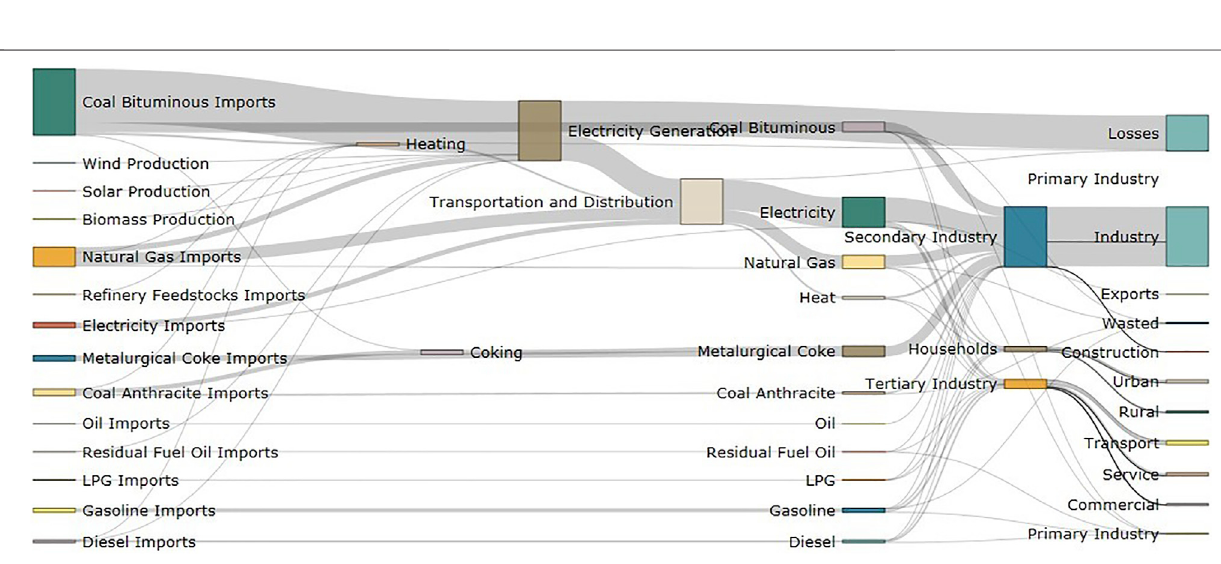
FIGURE 7 | Energy fl ow in